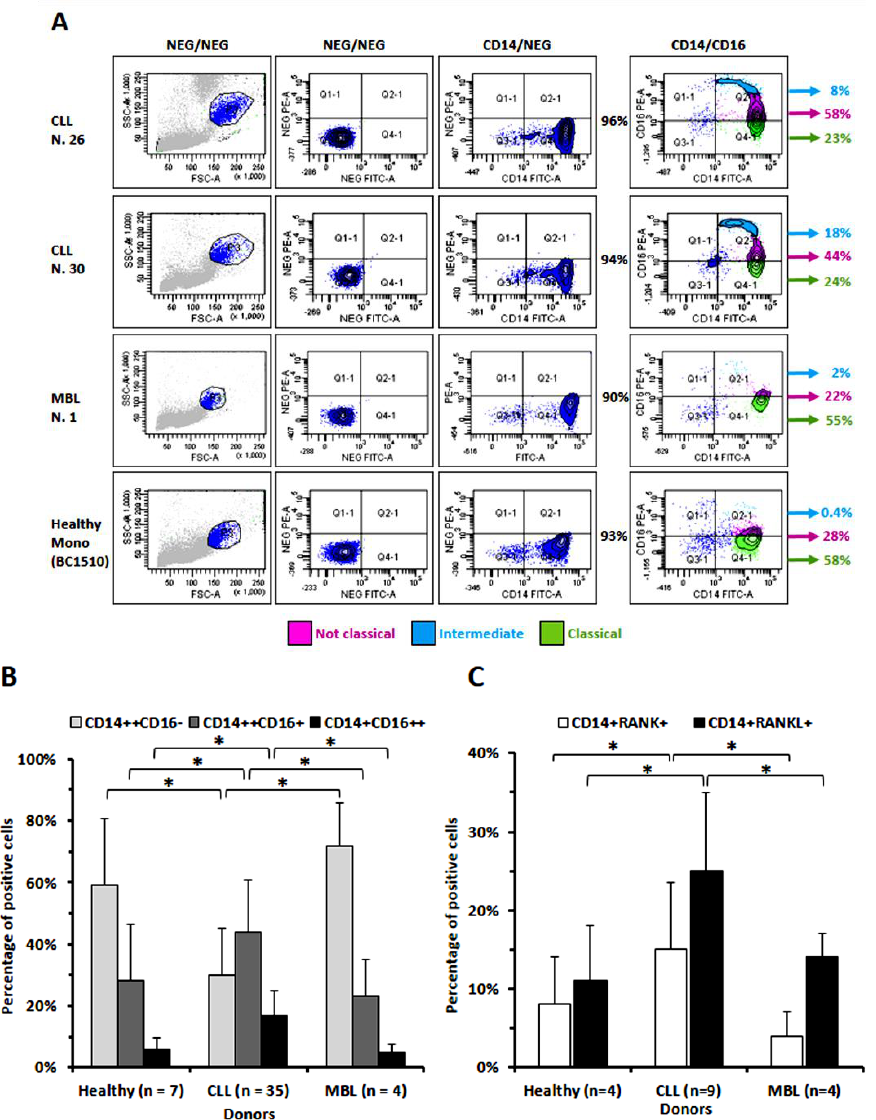
Figure 1. Cyto-fluorographic determination of the percentage of circulating “classical”, “intermediate” and “non-classical “monocytes, and assessment of monocytes expressing RANK and RANKL in a panel of CLL patients as compared with MBL patients or with healthy donors. ( A ) Dot plots display percentages of the three different monocyte subtypes (classical, intermediate and non-classical) in representative subjects of each group of donors examined. The three populations are here represented by different colors: light blue for non-classical, pink for intermediate and green for classical monocytes, as identified by 3 different gates designed on the basis of the CD16 expression levels. FMO (fluorescence minus one) control is the sample stained with CD14-FITC only that was performed in all the samples analyzed. ( B ) Histograms highlight that in CLL patients there was a relevant reduction in “classical” monocytes and a contemporary significant increase in the “intermediate” and “non-classical” subsets, with respect to MBL and healthy donors. ( C ) Monocytes from CLL patients showed a trend of increased positivity for both RANK and RANKL expression in comparison with healthy or MBL donors. Histograms are mean ± SD of the indicated n cases as evaluated in cyto-fluorographic analyses. Statistical significance was determined by using ANOVA and Tukey’s post hoc